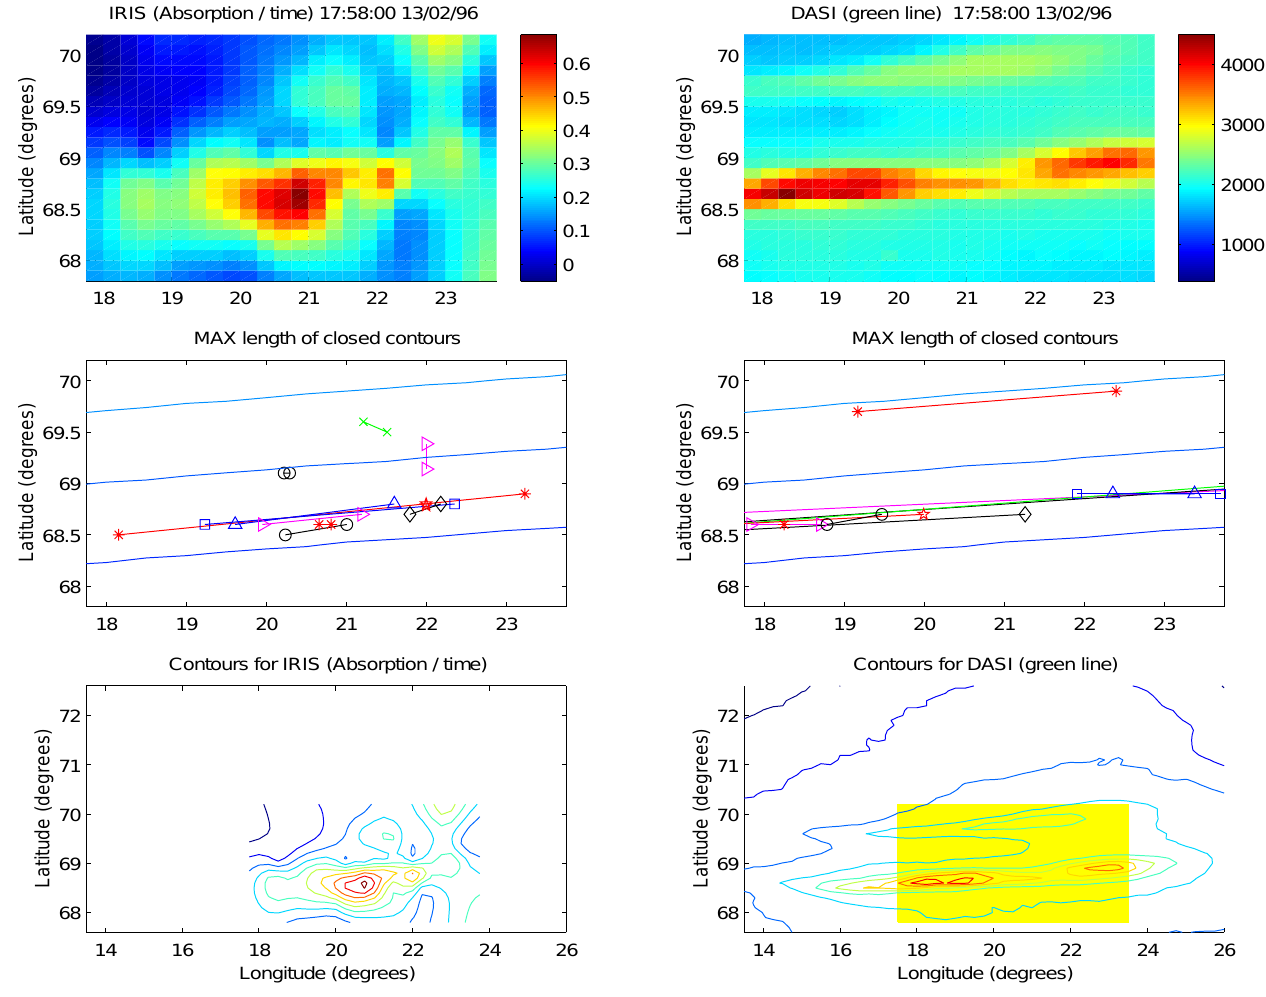
Fig. 3. (Top panels) Simultaneous observations by the IRIS and DASI systems in the common field of view of IRIS at 17:58UT. The middle panels show the length and orientation of the structures defined by the closed contours, the features show a clear alignment with the magnetic L-shells (the transverse blue lines across the panels). The bottom panels display the contour plots for the two data sets, in their respective fields of view. The yellow patch on the right shows the IRIS field of